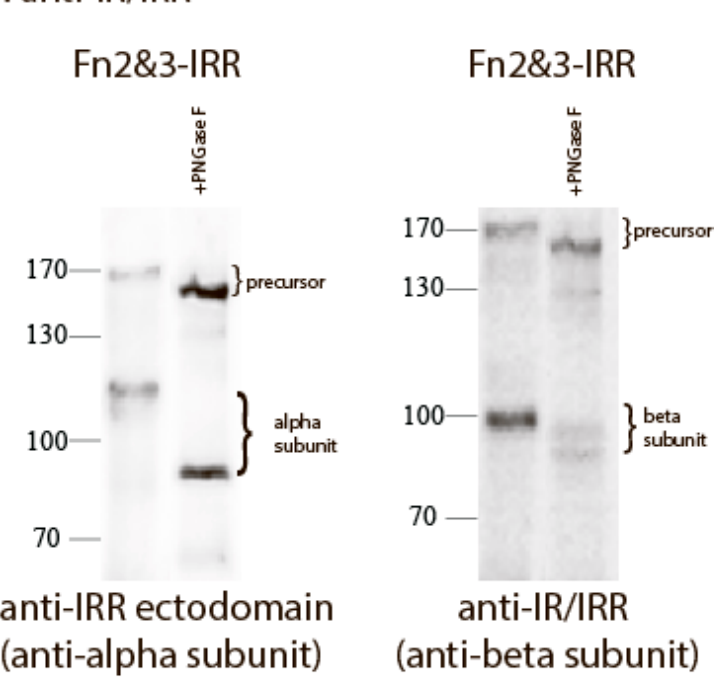
Figure 3. Treatment of Fn2&3-IRR with PNGase. Proteins from HEK 293 transfected cells was immunoprecipitated with anti-IR/IRR antibodies. The immunoprecipitates were treated without or with PNGase. After digestion, the reaction mixture was analyzed by Western blotting with indicated antibodies.